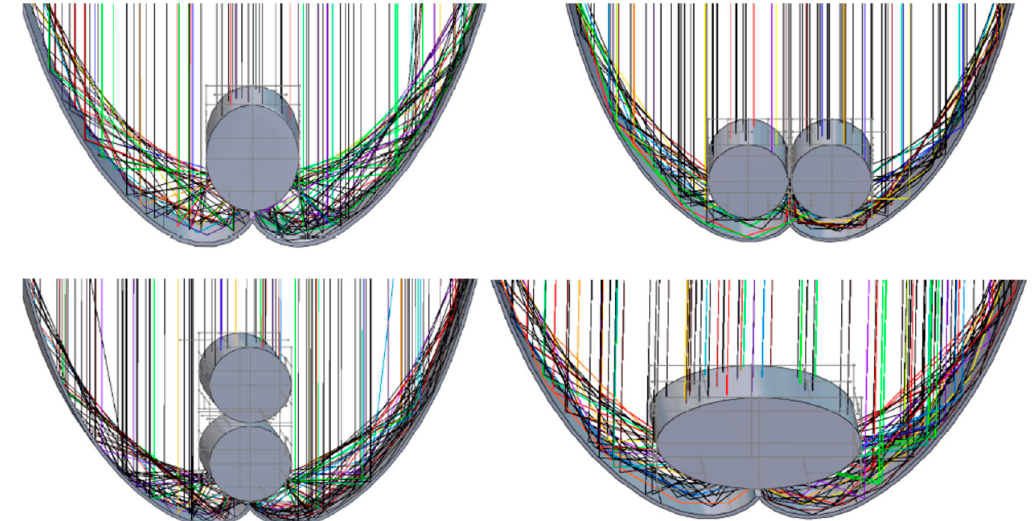
Figure 22. Ray-tracing simulation on single (upper left), double horizontal (upper right), vertical (lower left), and elliptical receiver (lower right) [52].